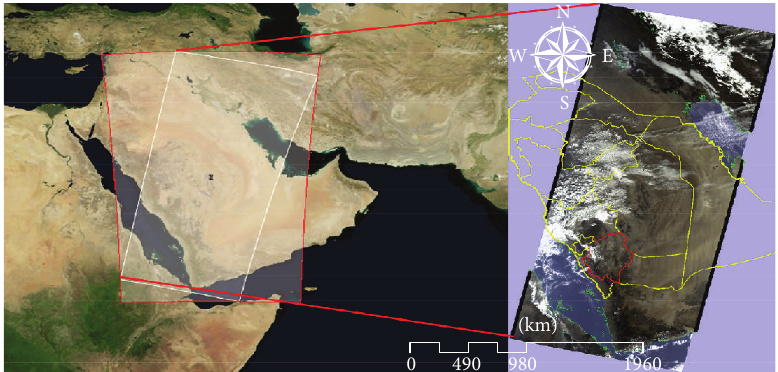
Figure 1: Administrative boundaries of KSA regions with location of the study area highlighted.